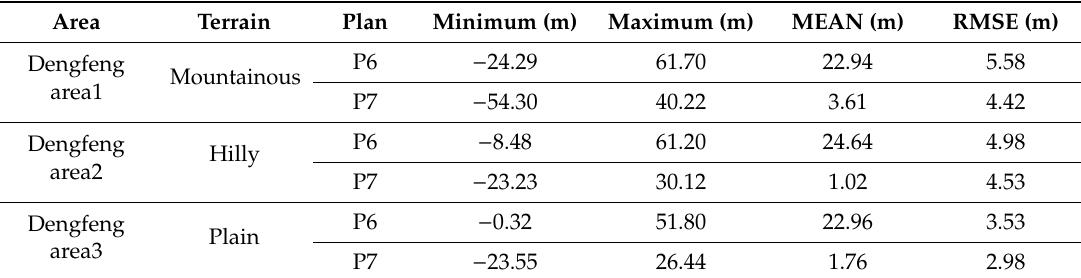
Table 5. Statistics for the digital surface model (DSM) elevation accuracy in Dengfeng area over various terrain